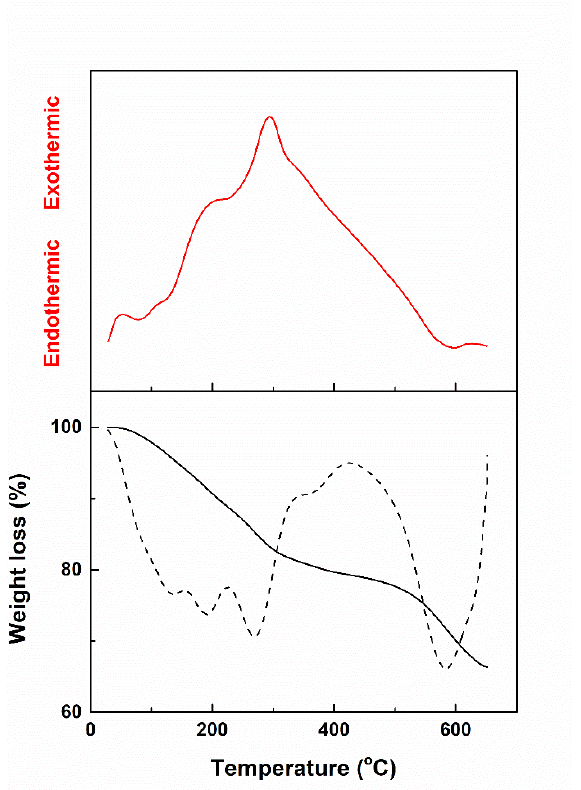
Figure 1. Complex thermal analysis of the dried gel (solid black curve - thermogravimetric analysis, dashed black curve - derivative of the thermogravimetric analysis with respect to time, red curve - analysis, dashed black curve—derivative of the thermogravimetric analysis with respect to time, differential thermal analysis). red curve—di ff erential thermal